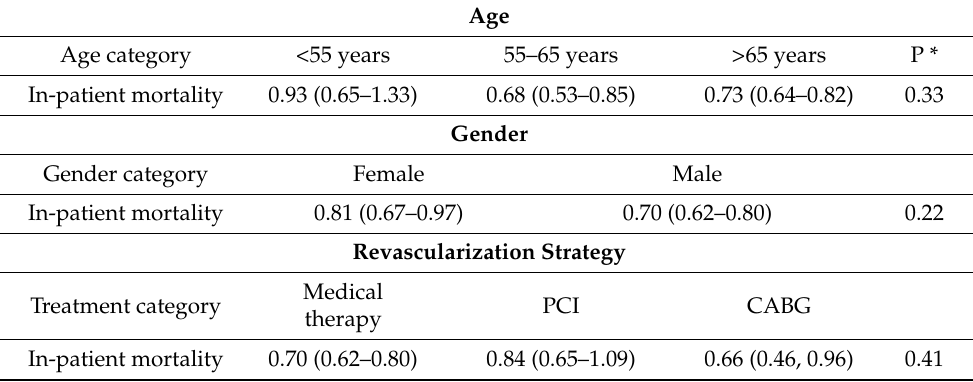
Table 3. Subgroup analysis: mortality by age, gender and revascularization